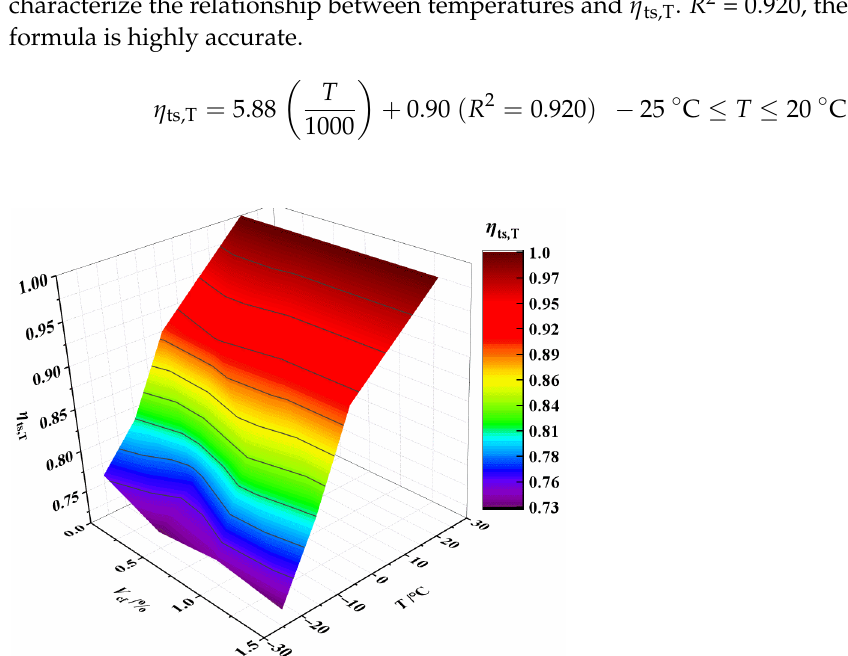
Figure 17. Relationship η ts,T vs. T.